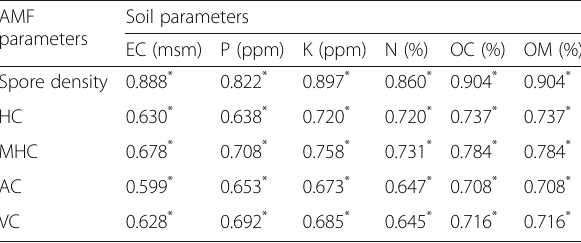
Table 10 Pearson correlation between soil parameters and AMF spore density (100 g − 1 of dry soil) and colonization (%) AMF